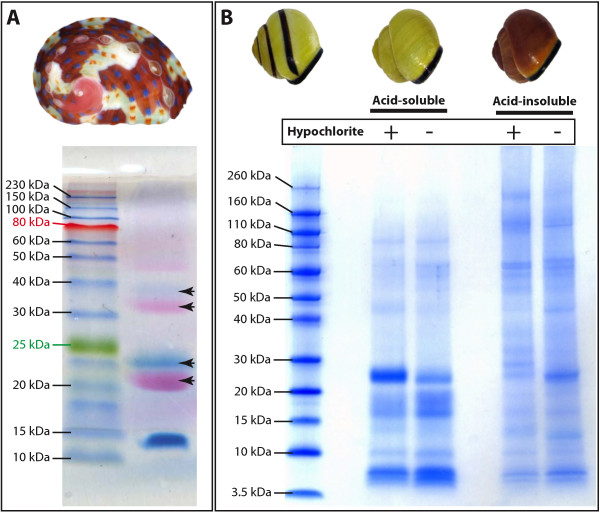
A comparison of the protein-associated pigments and PAGE profiles of proteins isolated from the shells of H. asinina and C. nemoralis. A. A representative SDS-PAGE gel of proteins isolated from shells of juvenile H. asinina. This gel is unstained (the protein marker is pre-stained) allowing the red and blue pigment-associated proteins to be visualized (arrows). B. A representative LDS-PAGE analysis of C. nemoralis acid-soluble and –insoluble proteins extracted from shell fragments either treated with or without a sodium hypochlorite-plus-sonication pre-treatment. Protein extractions which displayed such electrophoretic patterns were subjected to FASP (Filter-Aided Sample Preparation) sample preparation and proteomic analysis.